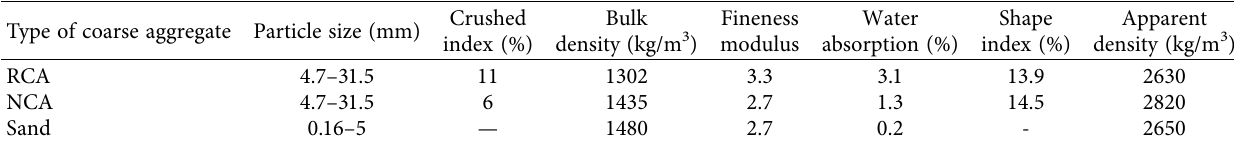
Table 3: Physical properties of aggregate.